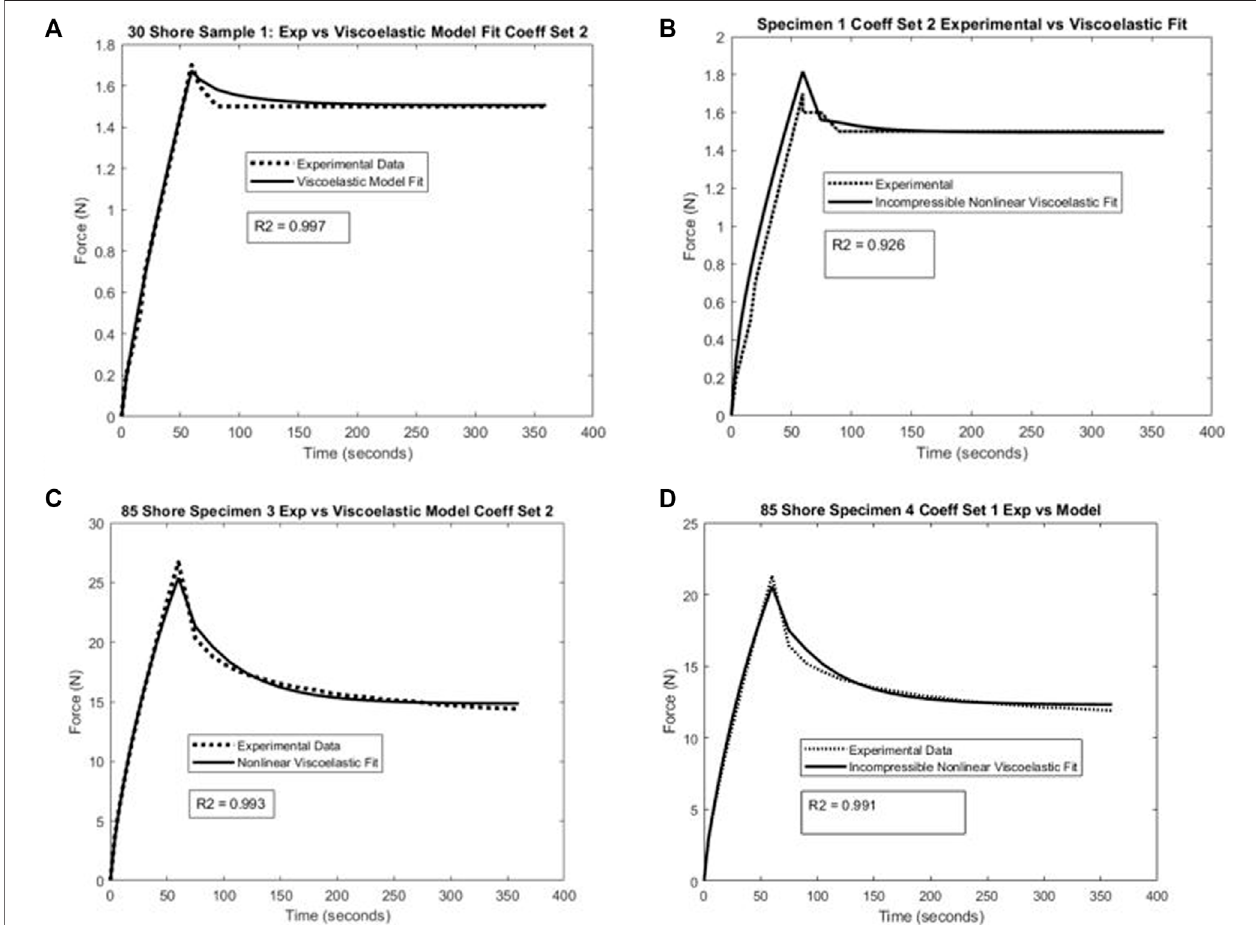
FIGURE3| Exampleofnonlinearviscoelasticconstitutivemodel fi tandexperimentaluniaxialtestdatafor (A) compressiblemodelandShore30materialspecimen, (B) incompressible model and Shore 30 material specimen, (C) compressible model and Shore 85 material specimen, and (D) incompressible model and Shore 85 material